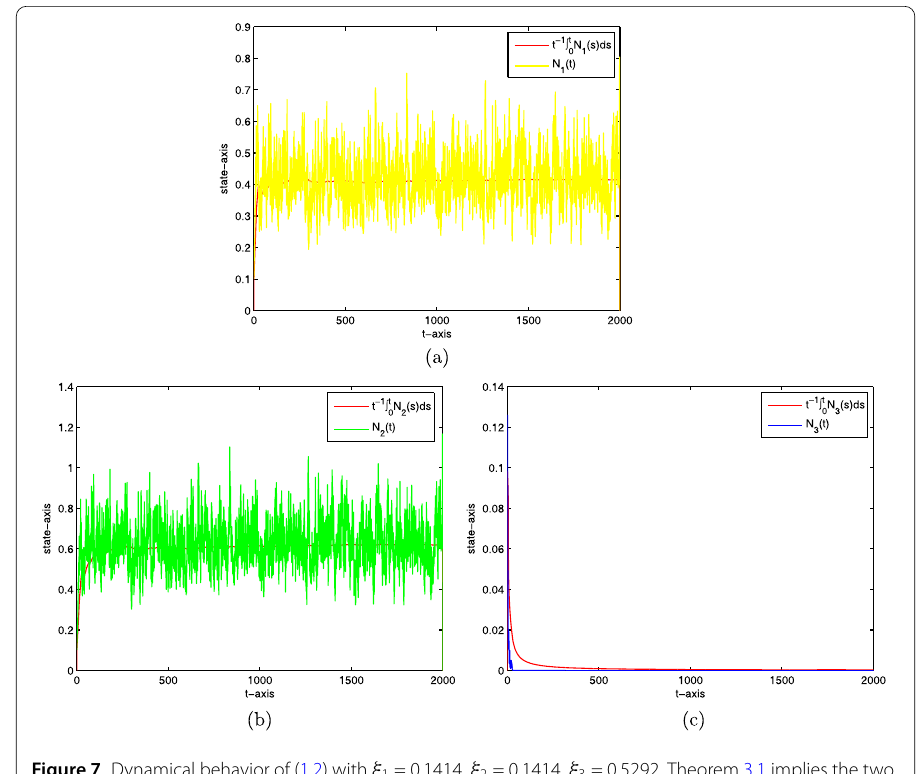
˜ (cid:9) 3 = 0.4286, A 33